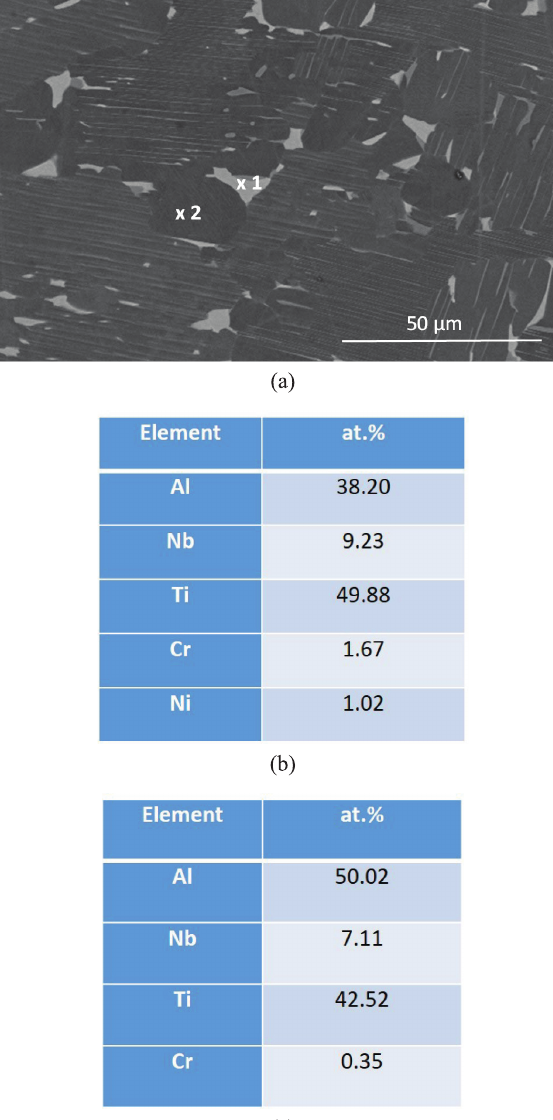
Fig. 1: (a) SEM images of Ti-46Al-7Nb-0.7Cr-0.1Si-0.2Ni, (b–c) chemical composition at points #1 and #2